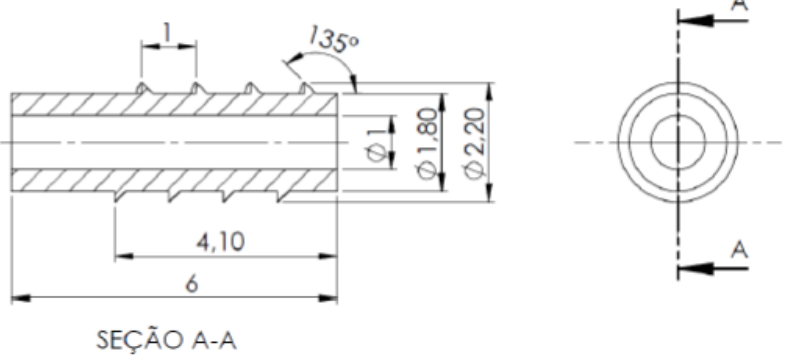
Figure 6. The main dimensions of the simulated orthopedic screw; dimensions in mm.